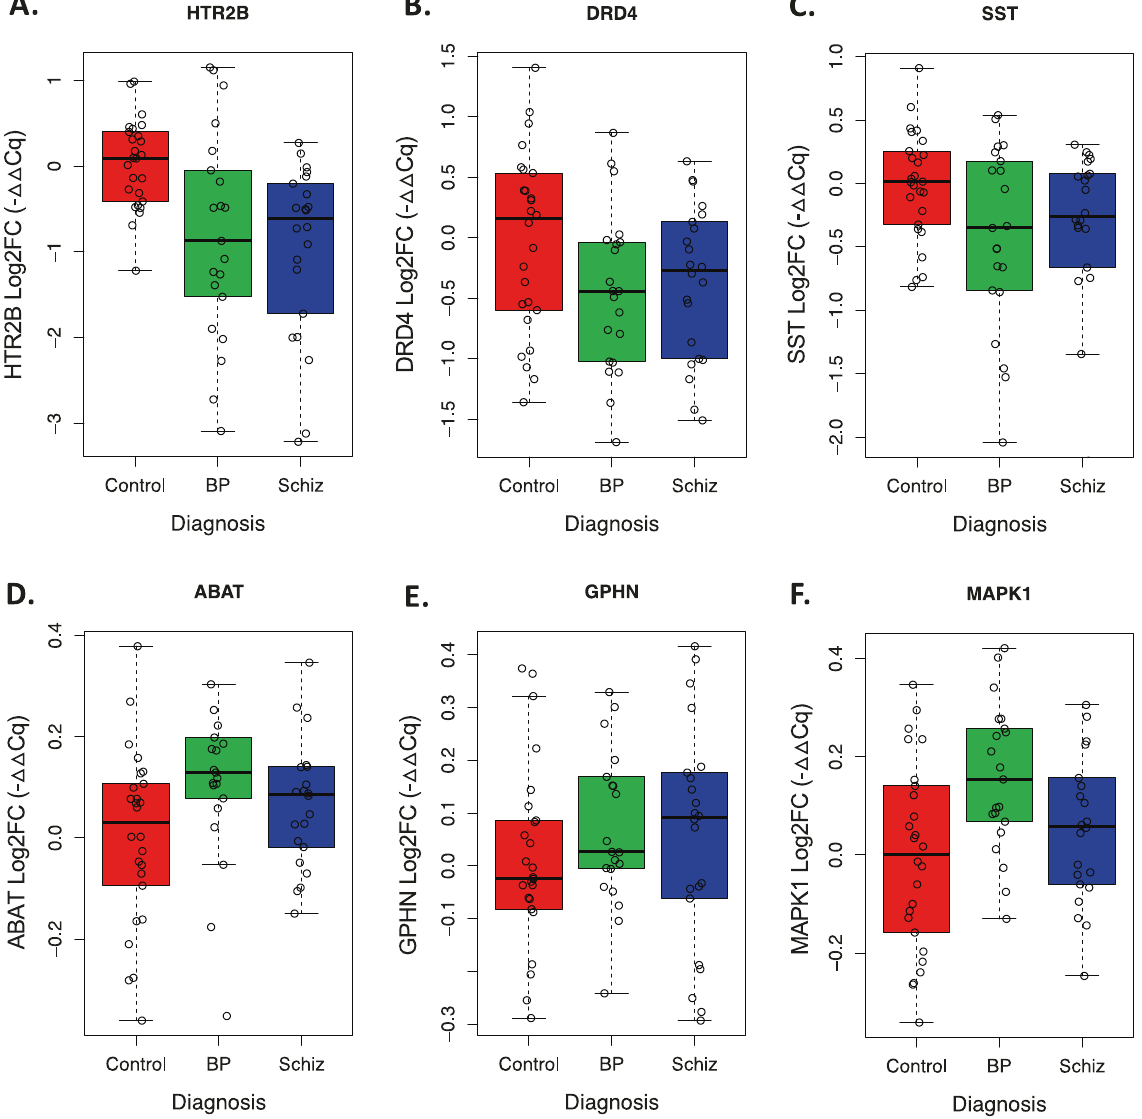
Fig. 1 Six target genes showed a relationship with the diagnosis that survived false discovery rate correction (FDR < 0.10) in our BA10 qPCR experiment. Boxplots illustrate the distribution of − ΔΔ Cq values ( log2 fold change (Log2FC), with the average for the CTRL group set as 0) for each subject within each diagnosis group (boxes = fi rst quartile, median, and third quartile, whiskers = range and/or 1.5× the interquartile range if there are outlying data points). For ease of visualization, each datapoint represents an average of the individual replicates for each subject, without the additional correction for in fl uential sources of biological variation (age, pH, sex) or technical variation (PMI, RIN, RNA Concentration, Card) provided by our multilevel statistical model (statistics reported below). A 5-Hydroxytryptamine Receptor 2B (HTR2B) showed an effect of diagnosis ( P = 0.000312, FDR = 0.0173), with a decrease in both bipolar disorder (BP, Log2FC = -0.681, P = 0.0270) and schizophrenia (SCHIZ, Log2FC = -0.980, P = 0.000903). B Dopamine Receptor D4 (DRD4) showed an effect of diagnosis ( P = 0.00196, FDR = 0.0495), with a decrease in both BP (Log2FC = -0.466, P = 0.00510) and SCHIZ (Log2FC = -0.347, P = 0.0244). C Somatostatin (SST) showed an effect of diagnosis ( P = 0.00223, FDR = 0.0495), with a trend towards a decrease in BP (Log2FC = − 0.308, P = 0.0935) and a decrease in SCHIZ (Log2FC = -0 . 467, P = 0.00689), D 4-aminobutyrate aminotransferase (ABAT) showed an effect of diagnosis ( P = 0.00166, FDR = 0.0495), with elevation in BP (Log2FC = 0.157, P = 0.00550) and a trend towards elevation in SCHIZ (Log2FC = 0 . 083, P = 0.0993). E Gephyrin ( GPHN) showed an effect of diagnosis ( P = 0.000283, FDR = 0.0173), with elevation in BP (Log2FC = 0.156, P = 0.00256) and SCHIZ (Log2FC = 0 . 101, P = 0.0295). F Mitogen-activated protein kinase 1 (MAPK1) showed an effect of diagnosis ( P = 0.00372, FDR = 0.0688), with elevation in BP (Log2FC = 0.135, P = 0.00113) and a trend towards elevation in SCHIZ (Log2FC = 0.0869, P = 0.0730). Complete statistical reporting for the full concatenated qPCR results can be found in Supplementary Table S5.